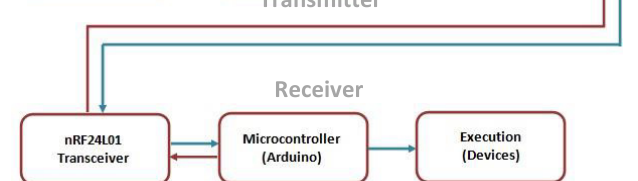
Figure 1. Flowchart of the system